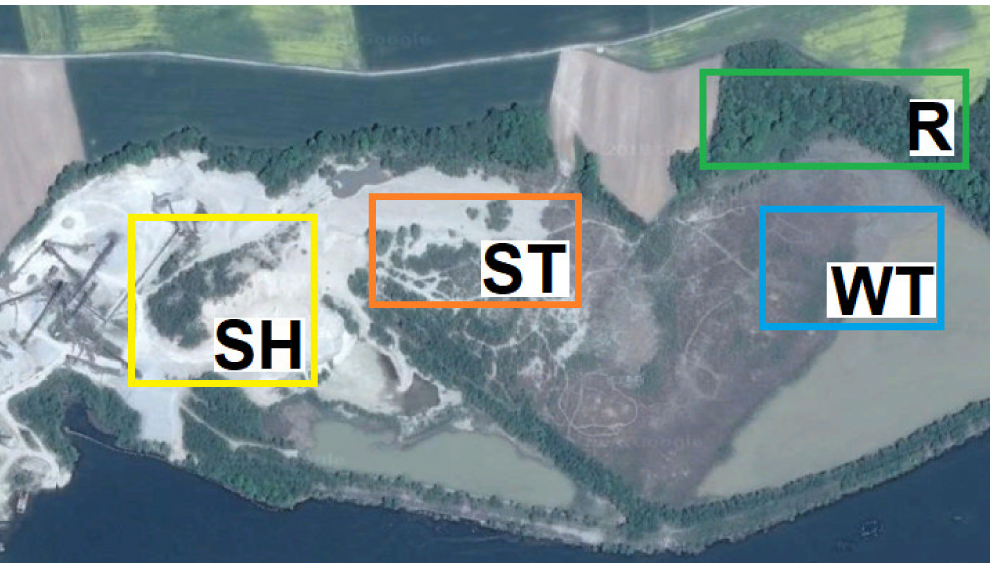
Figure 5. The spatial distribution of the study plots in the vicinity of the “W ó jcice” mine. Explanations: study site SH—zone of sand heaps, extreme dry conditions, advanced succession—11 study plots, site ST—bottom of the sedimentation tank, zone of sand deposits, initial and mid-advanced succession (maybe periodically flooded by pulp)—8 study plots, site WT—zone of clay deposits, moist areas, periodically flooded, various forms of succession—5 study plots and site R—control, situated in the adjacent forest—6 study